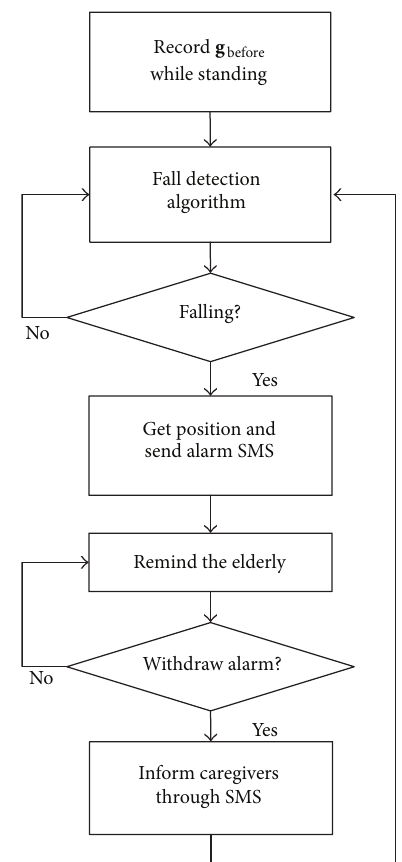
Figure 8: System software flow